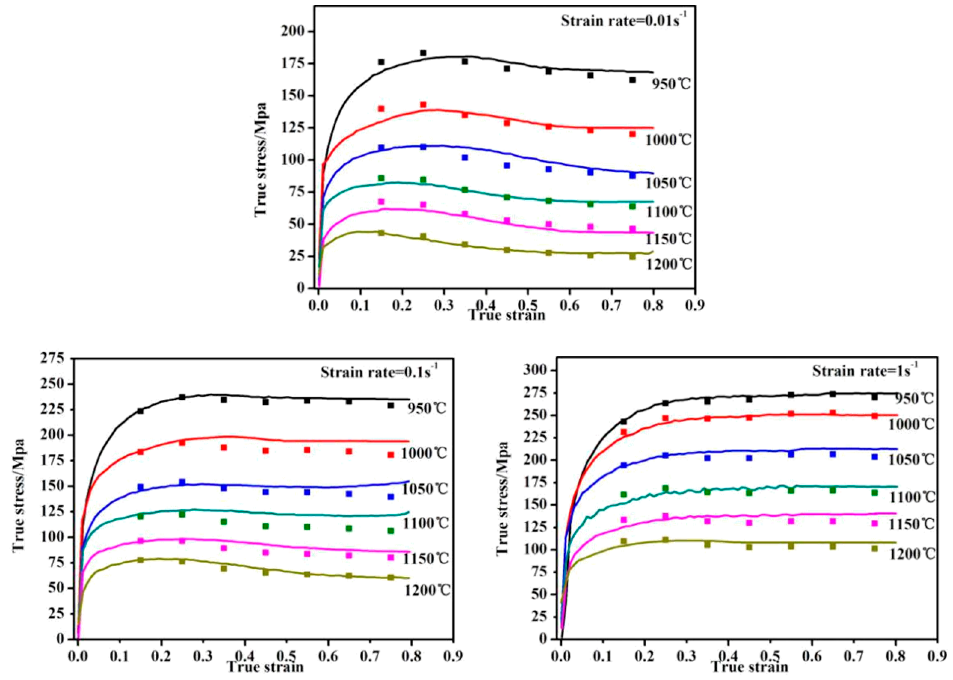
Figure 5. Comparison between predicted and experimental flow stress curves.